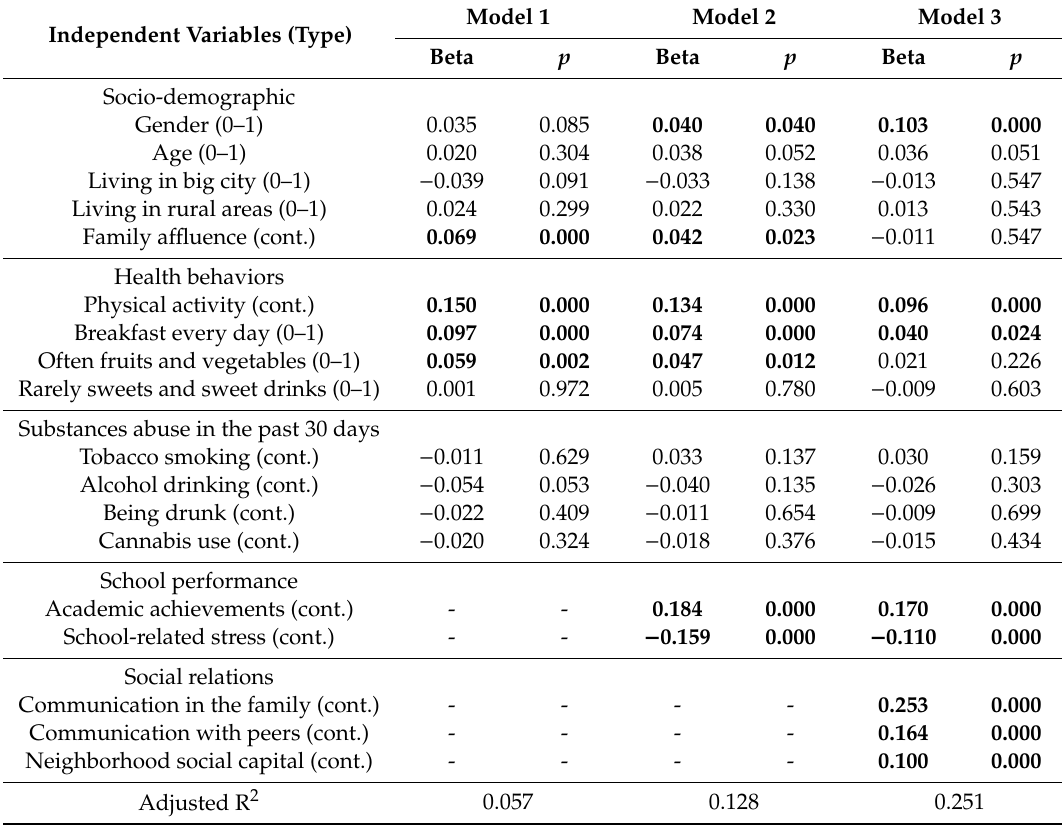
Table 3. Estimation of linear regression models—standardized beta values; dependent variable— standardized Positive Attitude Score